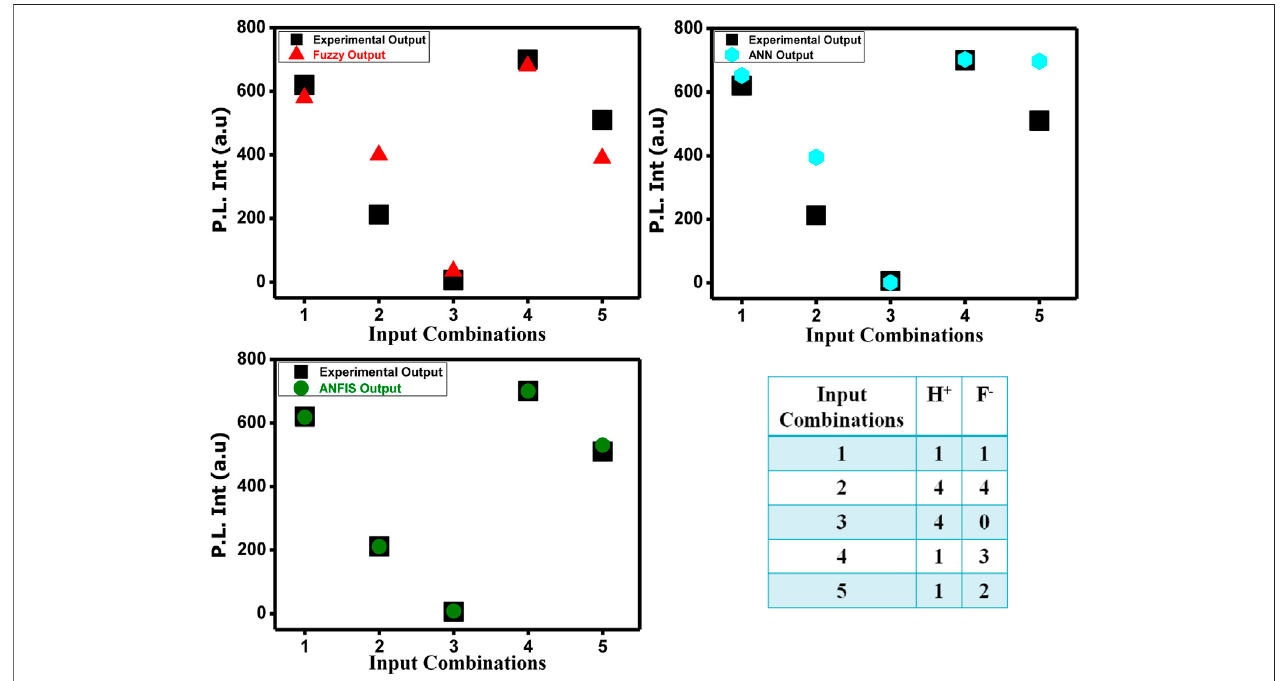
FIGURE 14 | Comparison between experimental emission output data and fuzzy, ANN, and ANFIS output data.